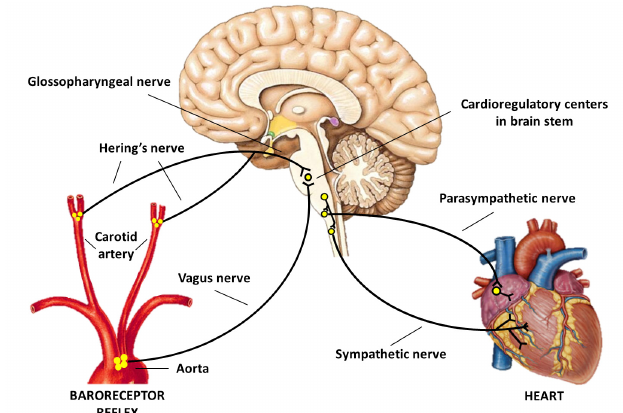
Figure 1. Overview the neural communication pathways between baroreceptor reflex and control of heart rate by autonomic nervous system.